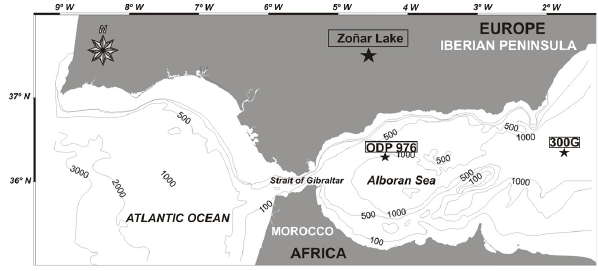
Fig. 1. Map of the continental and marine core